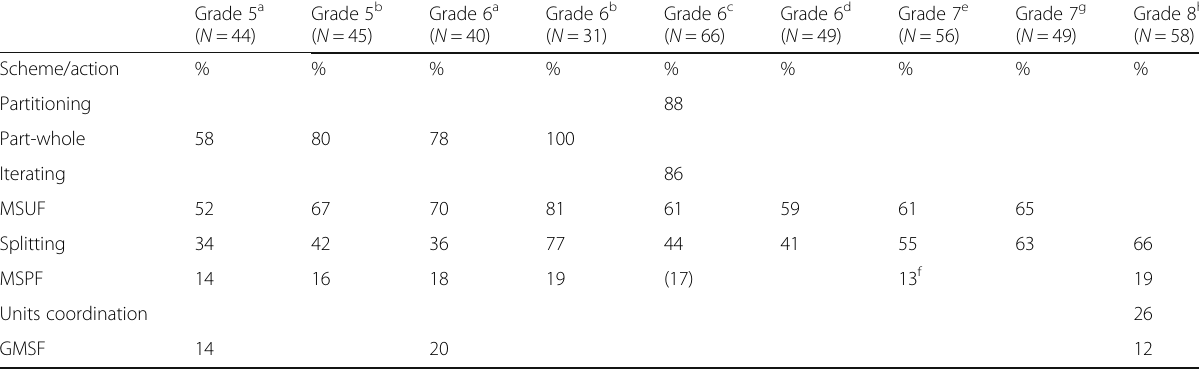
Table 4 Percentage of students with indication of fraction schemes and associated mental actions by